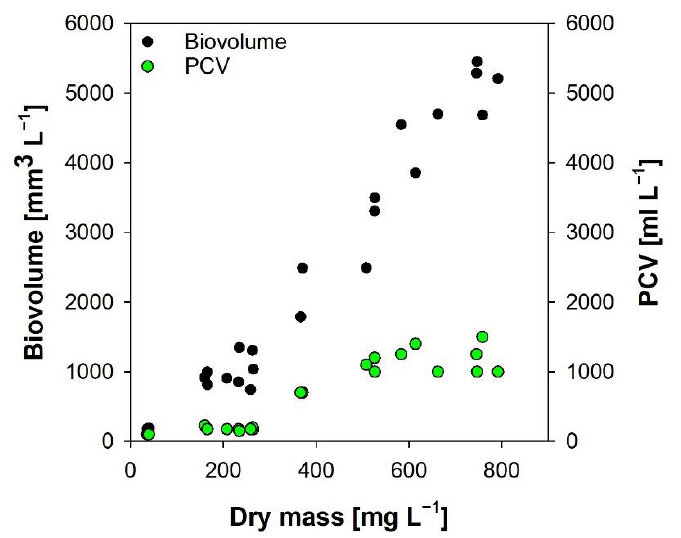
Figure 4. Relation of DM to biovolume and PCV. Limnospira fusiformis was cultivated for one